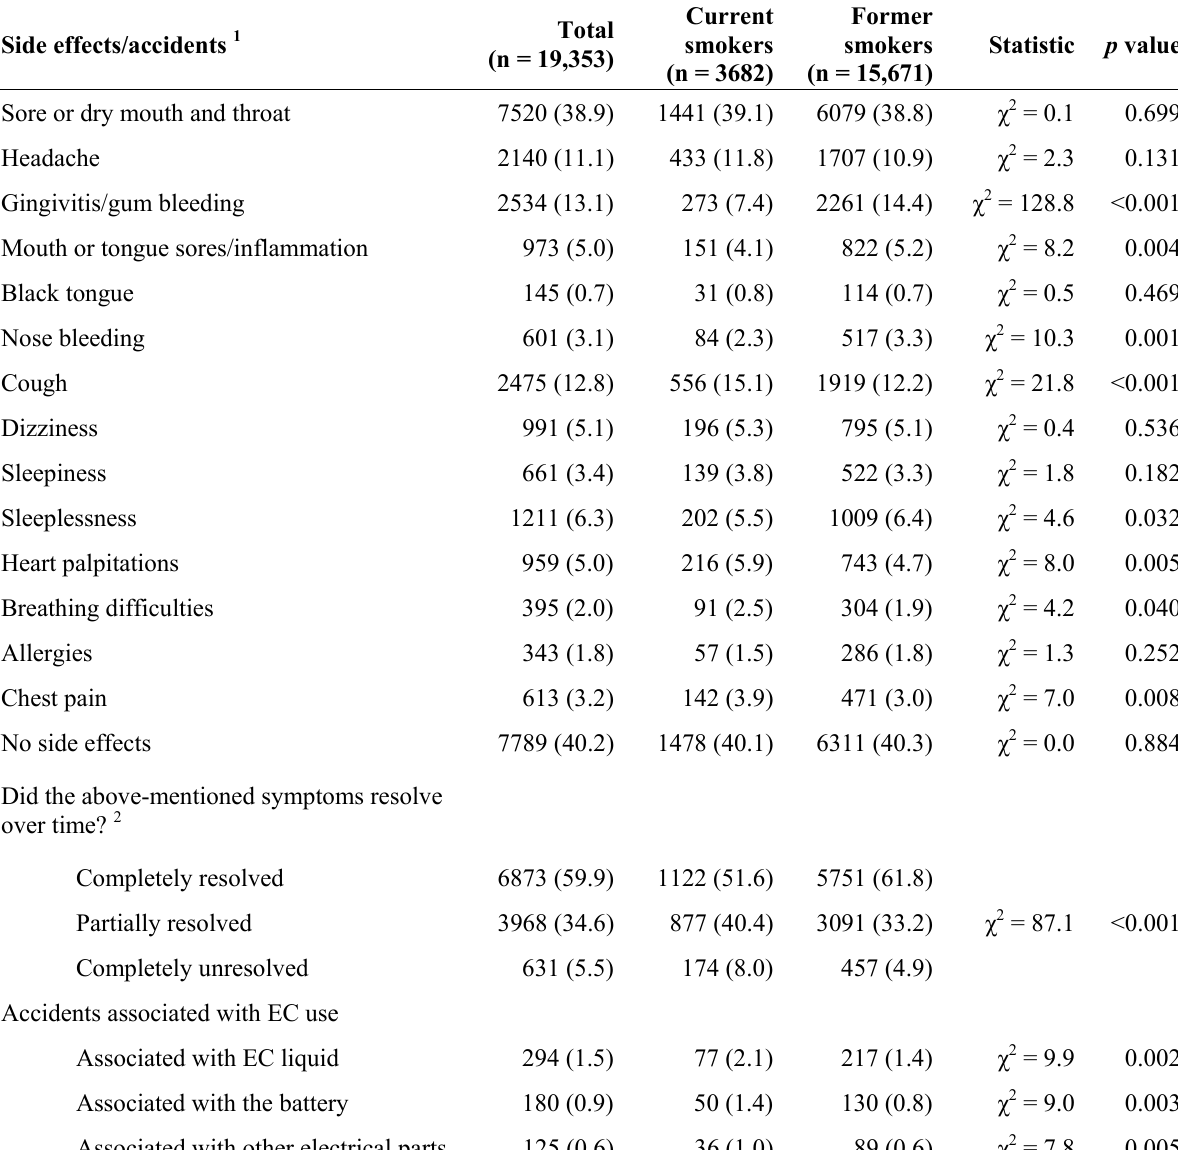
Table 4. Side effects and accidents associated with electronic cigarette